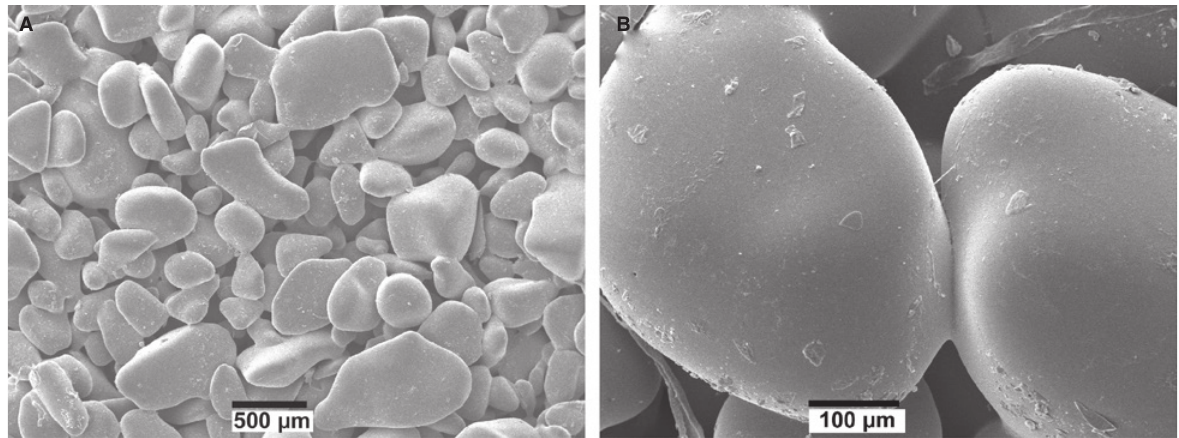
Figure 7: SEM images of MG30 recycled glass sintered at 725 ° C for 25 min: (A) low and (B) high magnification.